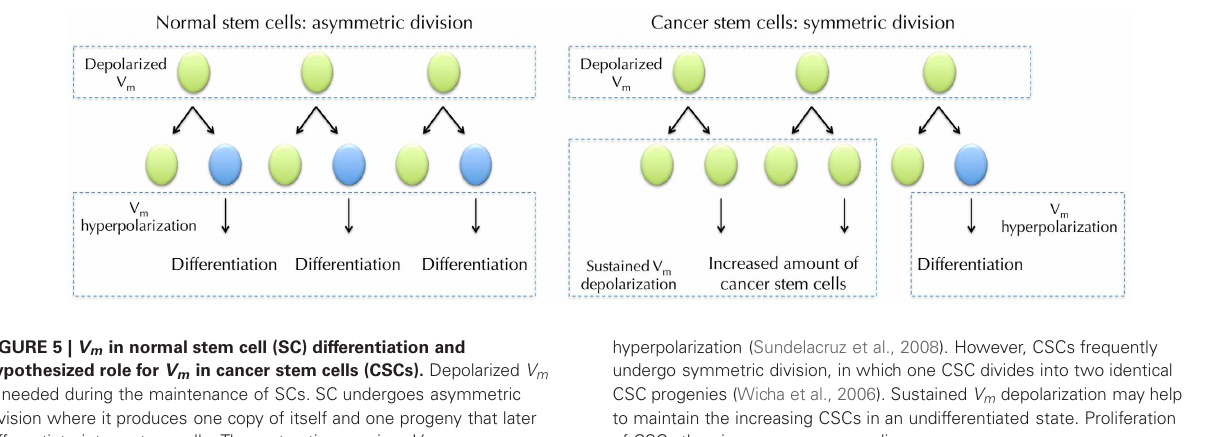
hyperpolarization (Sundelacruz et al., 2008). However, CSCs frequently undergo symmetric division, in which one CSC divides into two identical CSC progenies (Wicha et al., 2006). Sustained V m depolarization may help to maintain the increasing CSCs in an undifferentiated state. Proliferation of CSCs then increases cancer